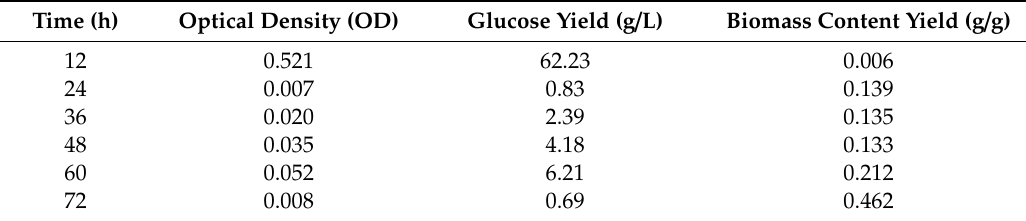
Table 3. Glucose and biomass content analysis during